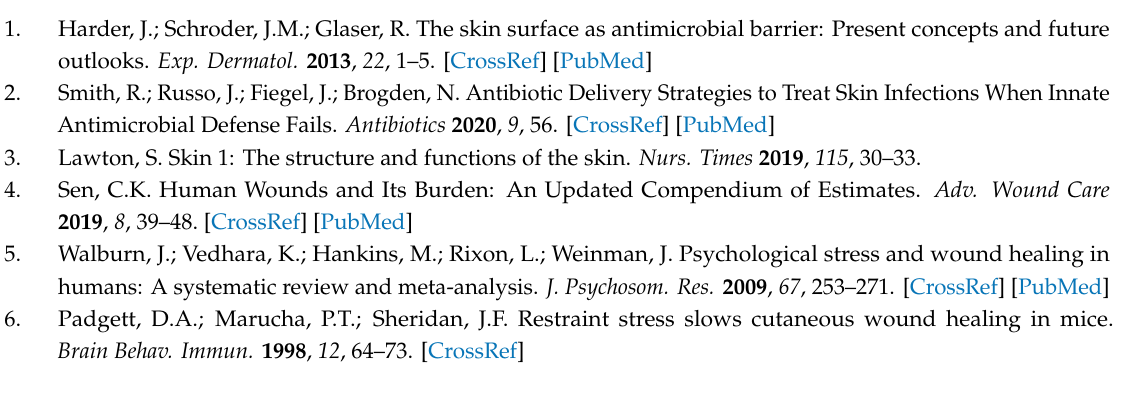
Table S1: Mass ( µ g) of diclofenac sodium delivered to receiver solution from each formulation throughout 24-h drug delivery studies; and Table S2: Mass ( µ g) of diclofenac sodium extracted per mass (g) of skin treated with each formulation after 24-h drug delivery